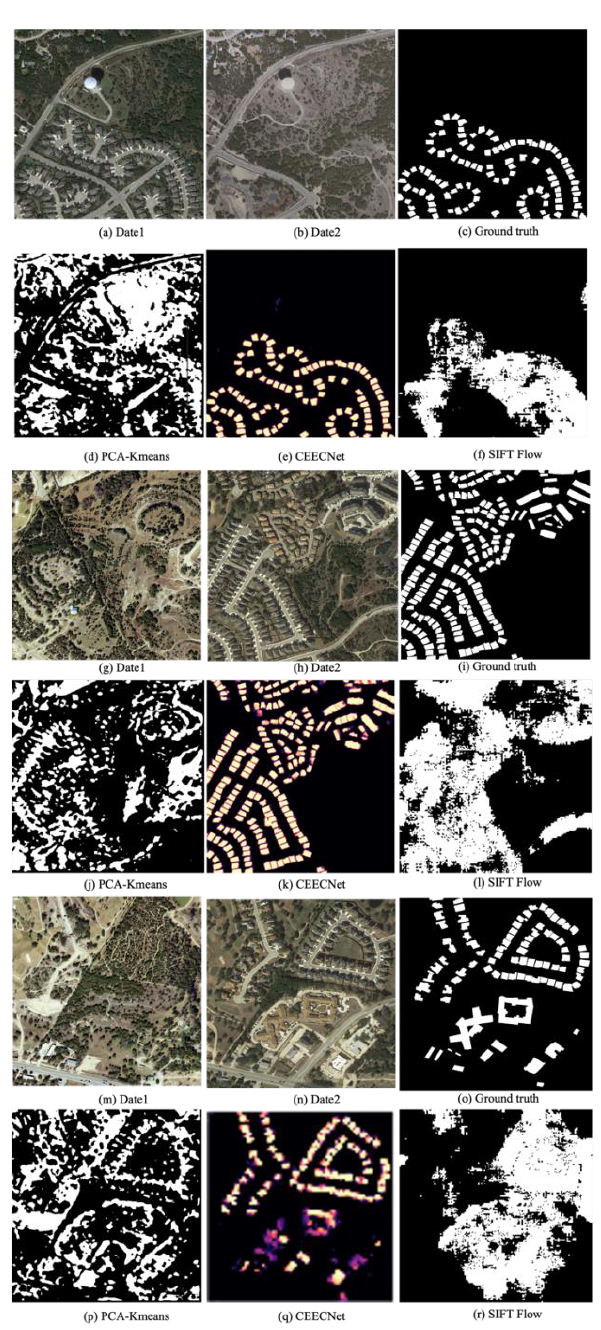
Figure 7. Results each odd row is the pair of input images and their ground truth. Each even row is the results of PCA- Kmeans, CEECNet and SIFT flow